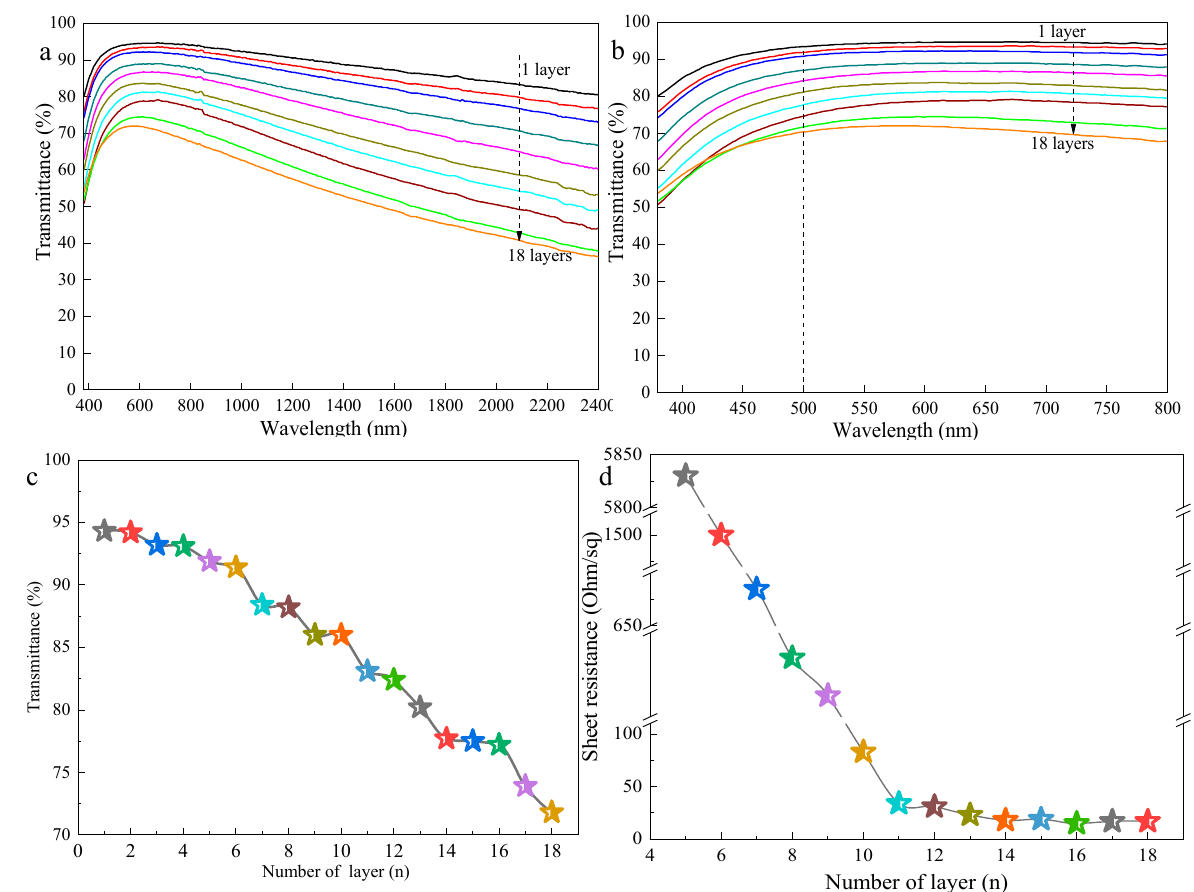
Figure 3. ( a ) Optical transmittance spectra of the samples; ( b ) local magnification of Figure 3a; ( c ) optical transmittance at 550 nm; and ( d ) sheet resistance of samples with different printed layers.